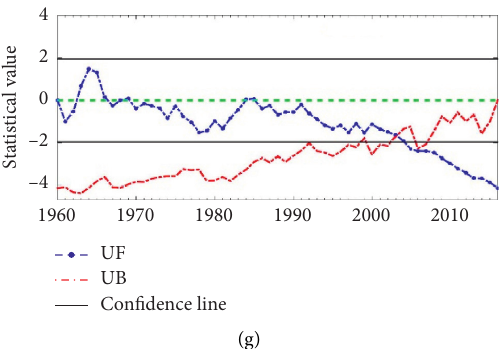
Figure 5: Change point analysis of mean annual streamflow through the stations. (a) Xiangcheng station. (b) Zhumadian station. (c) Gushi